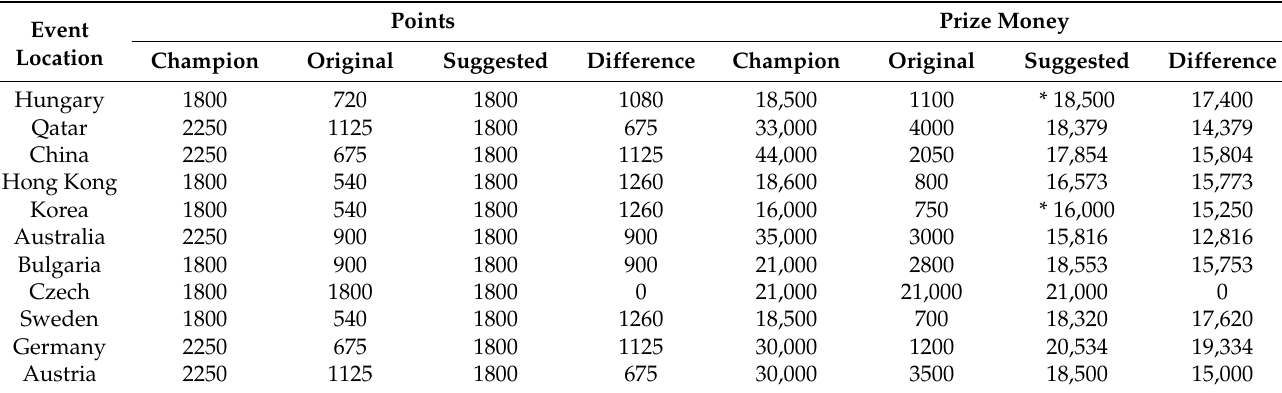
Table 7. Suggested output efficiency targets for the 2019 ITTF World